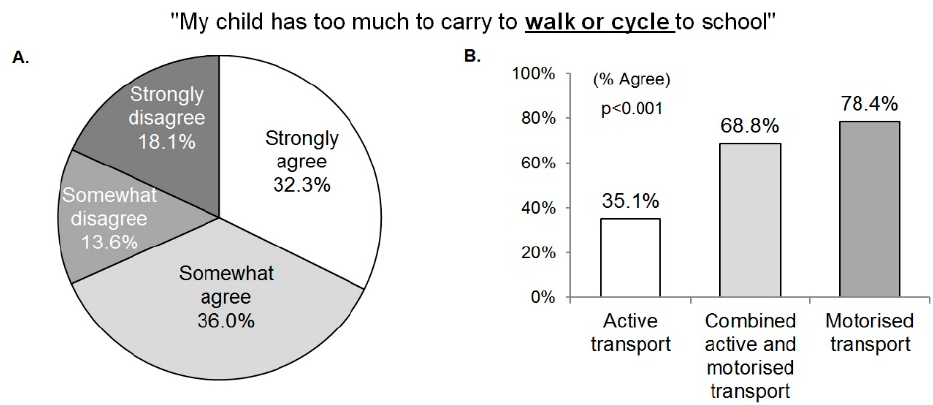
Figure 1. Parental agreement with the statement “My child has too much to carry to walk or cycle to